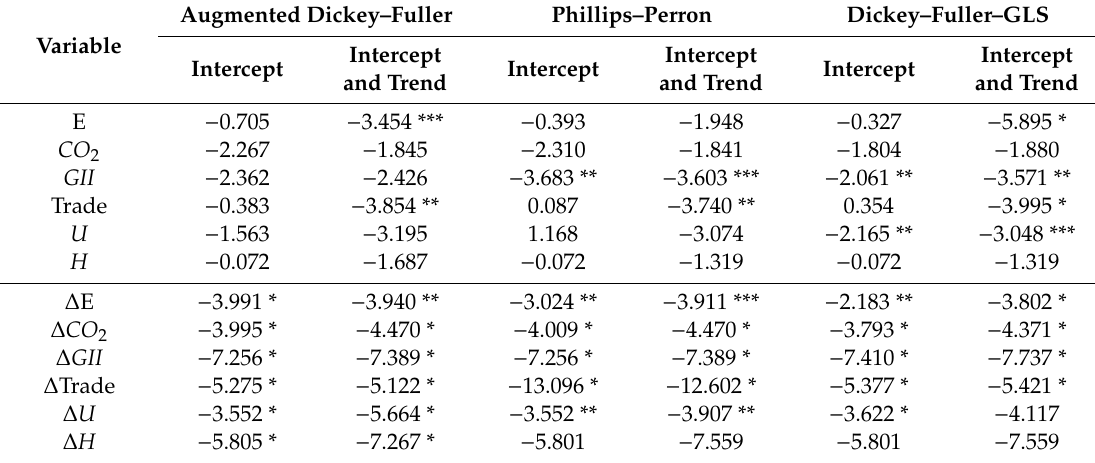
Table 6. The findings of linear unit root tests.